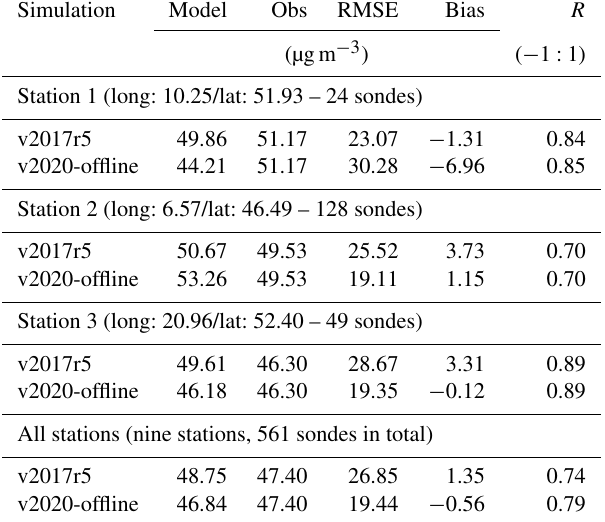
Table 3. O 3 vertical profile results for the v2017r5 and v2020r1 versions of the CHIMERE model. Scores are calculated by com- parison between ozonesonde observations and the corresponding model vertical distribution of ozone. Statistical scores are presented for O 3 ; correlations for each model level are shown in Fig. 6. The coordinates and the number of sondes are given on top of each col-